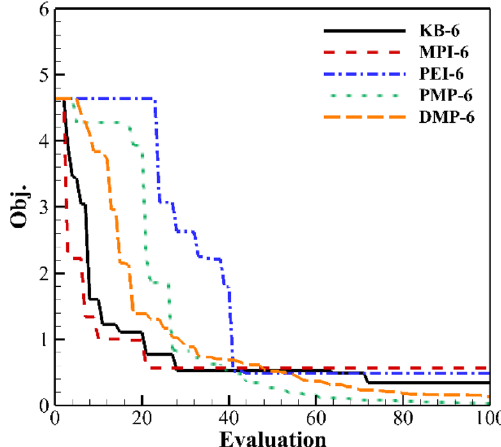
Figure 19. Convergence history of six updated